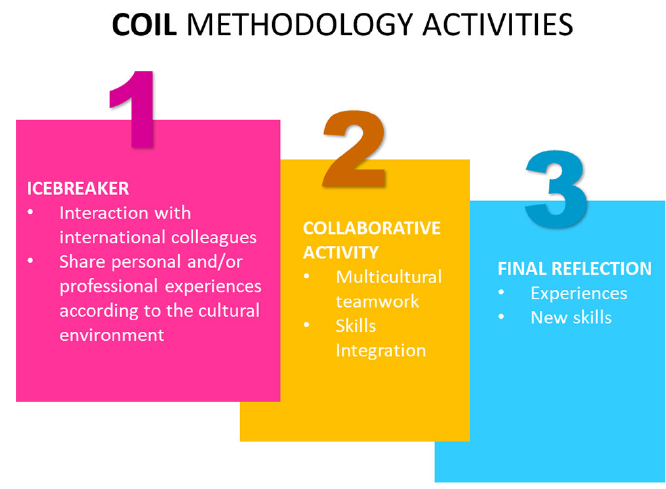
Fig. 2. COIL methodology implemented in this